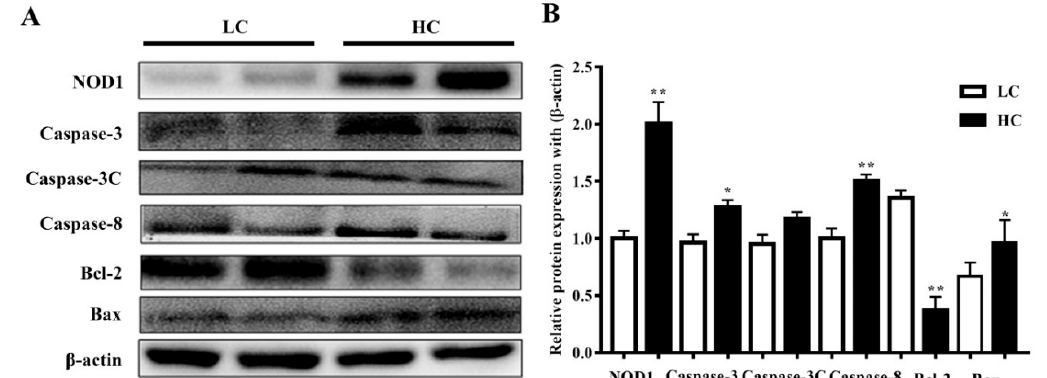
Figure 4. ( A ) The protein expressions of NOD1, Caspase-3, Caspase-8, and Bax were observed to be higher in the mammary gland tissue of the HC group compared to the LC group. Bcl-2 protein expressions were markedly higher in the LC than in the HC group. ( B ) Figure b represents their histogram. * p < 0.05 and ** p < 0.01 versus control.